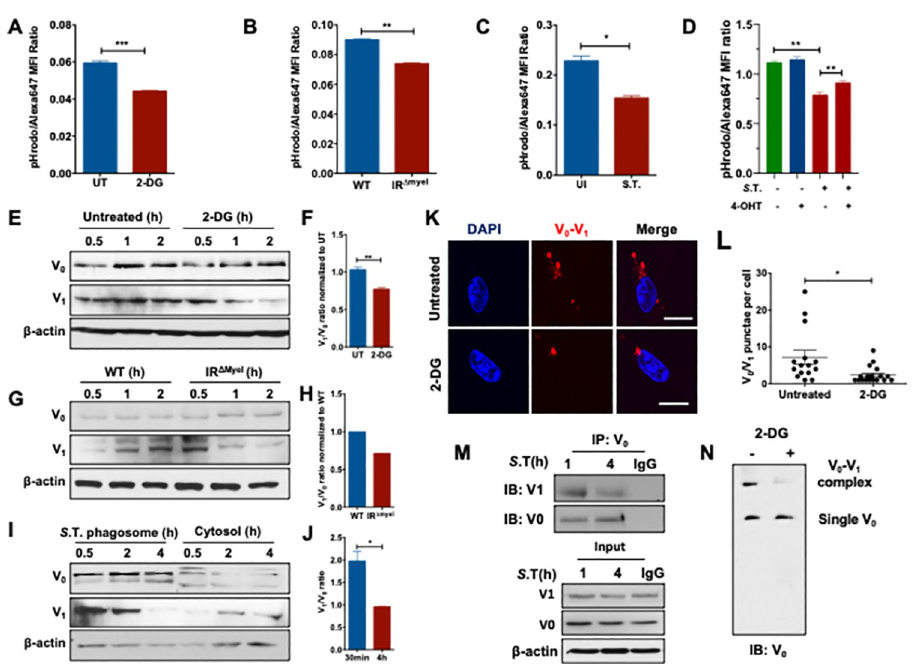
Fig 5. Glycolysis critically regulates the acidification of phagosomes and assembly of v-ATPase complex. (A) MFI of pH-sensitive pHrodo-E. coli particles in BMDMs untreated (UT) or pre-treated with 2-DG, normalized to Alexa647 MFI (n = 3). (B) MFI of pHrodo-E. coli particles in WT and IR Δ myel BMDMs normalized to Alexa647 MFI (n = 3). (C) MFI of pHrodo-E. coli particles in S. Typhimurium-infected WT BMDMs (2h p.i.) normalized to Alexa647 MFI (n = 3). (D) MFI of pHrodo-E. coli particles in 4-OHT-treated BMDMs infected with S. Typhimurium for 2h normalized to Alexa647 MFI (n = 3). (E-F) Expression of v-ATPase subunits (V0, V1) in isolated bead-containing phagosomes from untreated and 2-DG-treated BMDMs. The image shown is representative of 3 individual experiments. Immunoblot band intensities were quantified using ImageJ and the V1/ V0 ratio was determined and plotted (n = 3). (G-H) Expression of v-ATPase subunits (V0, V1) in isolated bead phagosomes from WT and IR Δ myel BMDMs. Western blot was quantified and V1/V0 ratios are shown. Expression of v-ATPase subunits (V0, V1) in isolated S. Typhimurium phagosomes and cytoplasm. V1/V0 ratios were quantified and plotted. (I-J) V0 subunit A was immunoblotted from isolated S . Typhimurium phagosomes and probed for V1 subunit B. (K-L) Proximity Ligation Assay (PLA) analysis of V0-aldolase A interaction in 2-DG treated BMDMs. The image shown is representative of 3 individual experiments. (M) Immunoprecipitation of V0 subunit from S . Typhimurium infected phagosomes at indicated times probed for V1, V0 and actin. Rabbit IgG was used as a control for immunoprecipitation. (N) Phagosomes isolated from 2DG-treated and untreated macrophages were subjected to Native-PAGE and immunoblotted for v-ATPase subunits V0 and V1. macrophages (Fig 5G and 5H) and from fasentin-treated macrophages when compared to WT controls ( S6C Fig ). Notably, we did not observe differential amounts of V and V sub- 0 1 units in the total cell lysates of 2-DG-treated macrophages compared to controls ( S6D Fig ) or in fasentin-treated cells compared to untreated controls ( S6E Fig ). These findings suggest that impaired glycolysis prevents the assembly of the v-ATPase complex rather than the expression itself. V recruitment on to phagosomes containing S . Typhimurium was also reduced, while 1 V levels did not vary significantly between different time points ( Fig 5I ). The decline in V on 0 1 phagosomes harboring S . Typhimurium corresponded with the time when glycolysis was inhibited ( Fig 2A–2E ). Similarly, Proximity Ligation Assay (PLA) also showed reduced inter- action of V and V in 2-DG-treated macrophages ( Fig 5K and 5L ). The decreased interaction 0 1 between V and V upon S . Typhimurium infection was also confirmed by PLA ( S6F and S6G 0 1 Fig ). We also immunoprecipitated (IP) V from isolated S . Typhimurium-containing phago- 0 somes and observed the complex formation of V and V however, V binding to V was 0 1 1 0